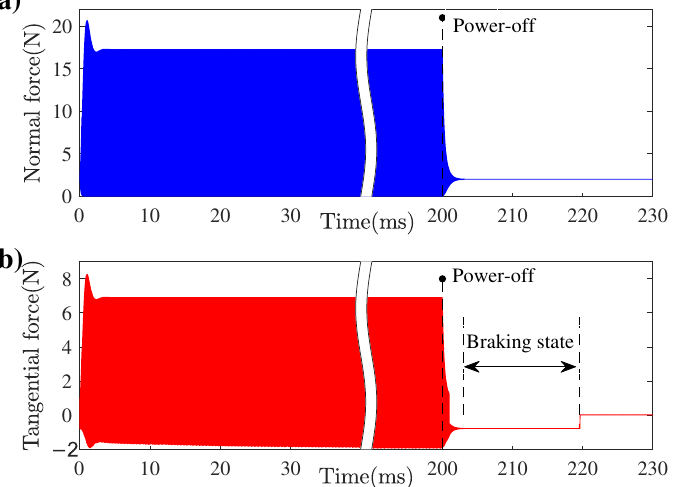
Figure 22. Transient forces transmission of contact interfaces: ( a ) normal contact force; ( b ) tangential contact